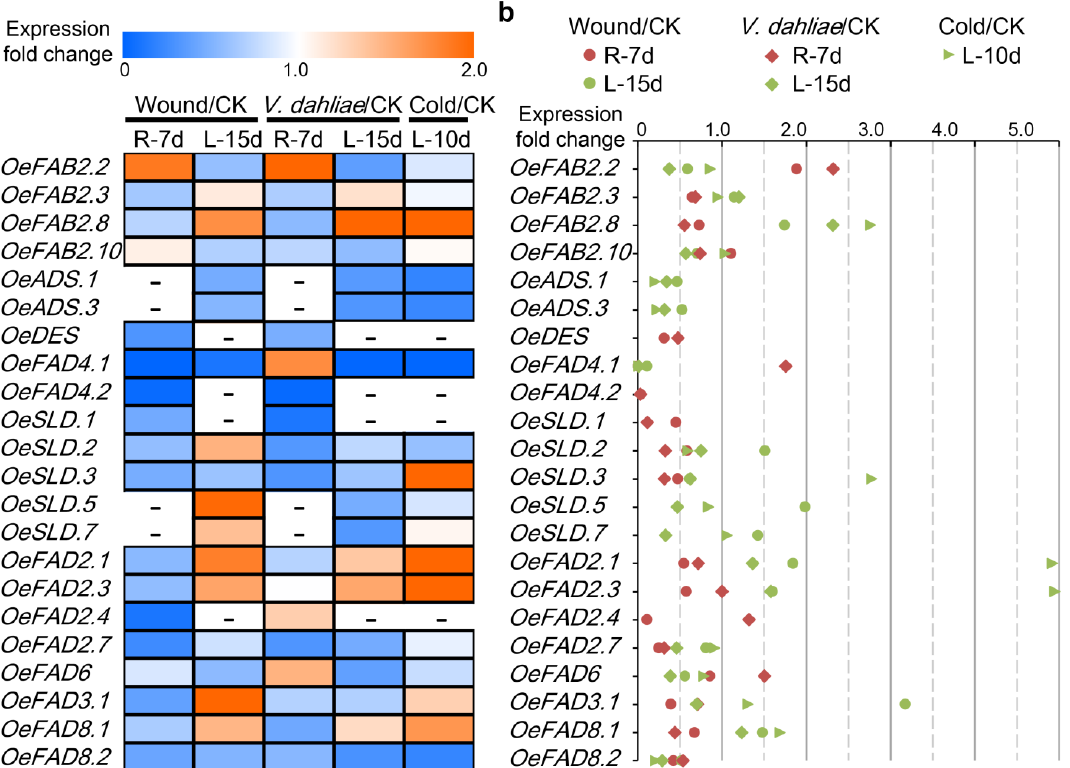
Figure 5. Expression heatmaps ( a ) and values ( b ) of FAD genes induced by different stresses in olive. Stress-induced expression profiles of FAD genes under wound, Verticillium dahlia and cold (PRJNA256033) were obtained from NCBI. Wound and V. dahliae were involved in the roots (R) and leaves (L) after 7 and 15 days of stress treatment, and cold was involved in the leaves after 10 days of stress treatment. The Transcripts Per Million (TPM) was calculated as the expression level and the up-regulated or down-regulated genes were identified with the fold change of stress/CK ≥1.5 or ≤0.5.